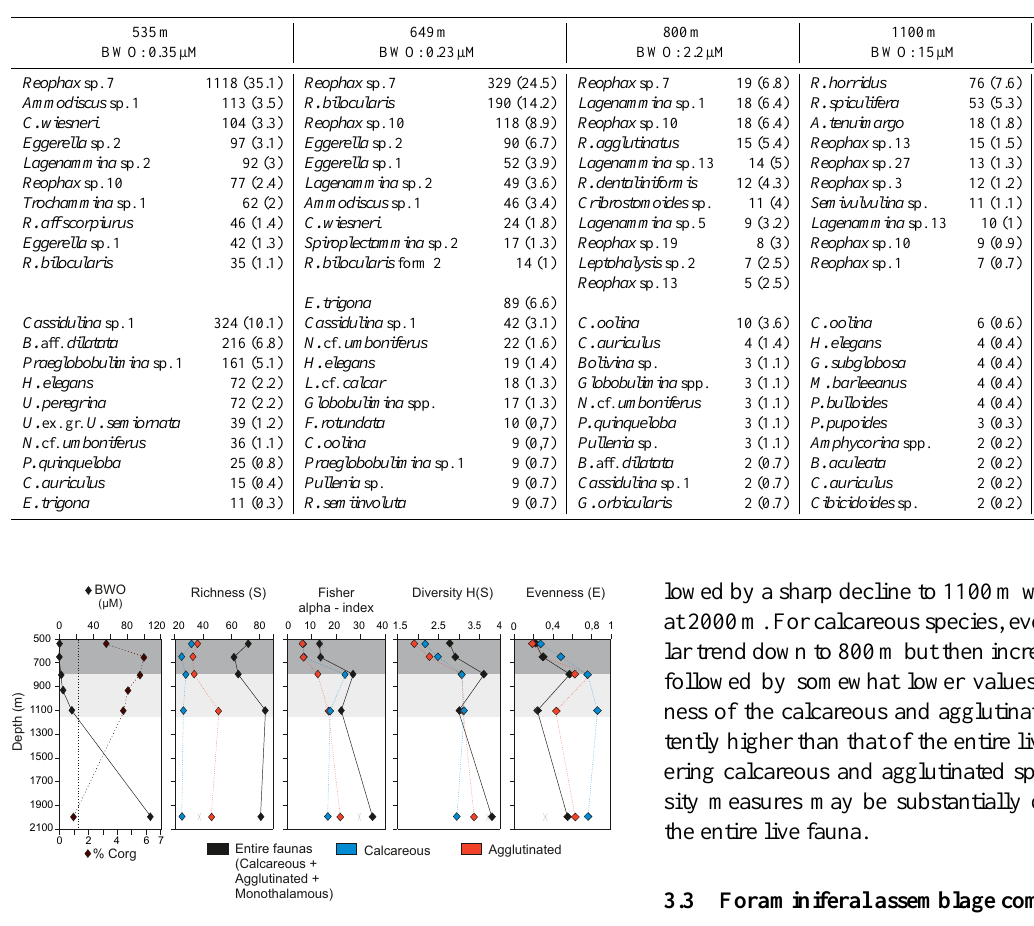
Table 1. Top 10 ranked species at each site. The number to the right of each name indicate counts of specimens with the relative abundances (%) in brackets.